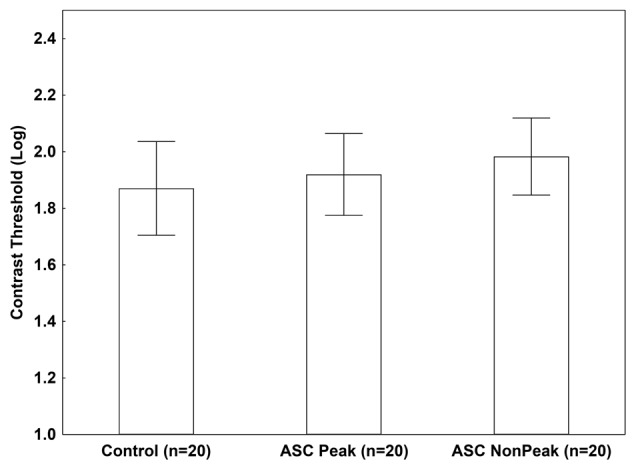
Mean log-contrast threshold (95% confidence intervals) in people with autism spectrum conditions (ASC) exhibiting a Block Design peak performance (ASC Peak), an average Block Design performance (ASC Non-Peak), and neurotypical (non-autistic) control volunteers. In this condition, a single Gabor stimulus was presented without masks. There were no statistically significant between-group differences (p > 0.5).